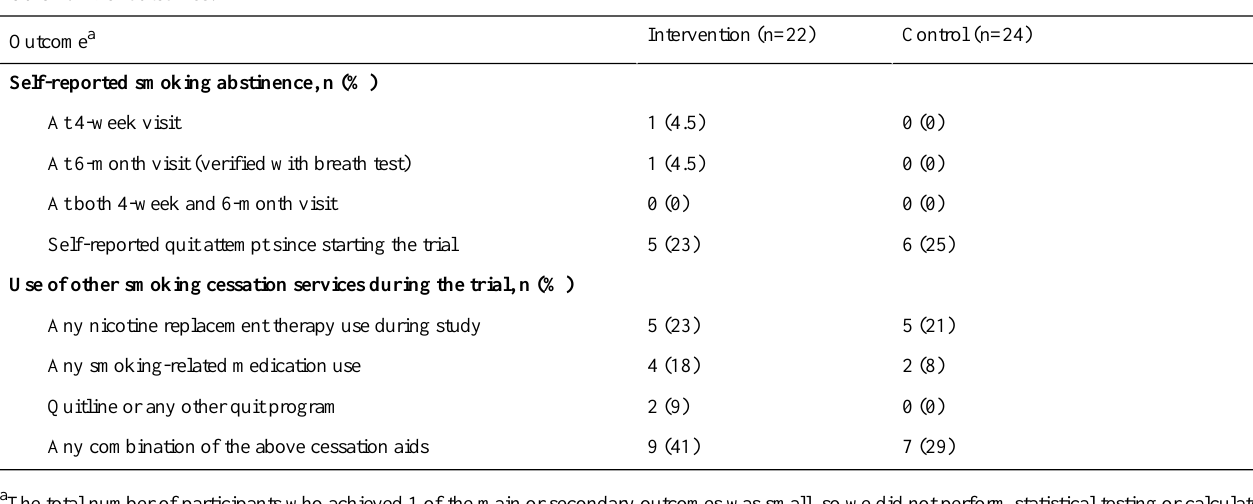
Table 2. Trial outcomes.